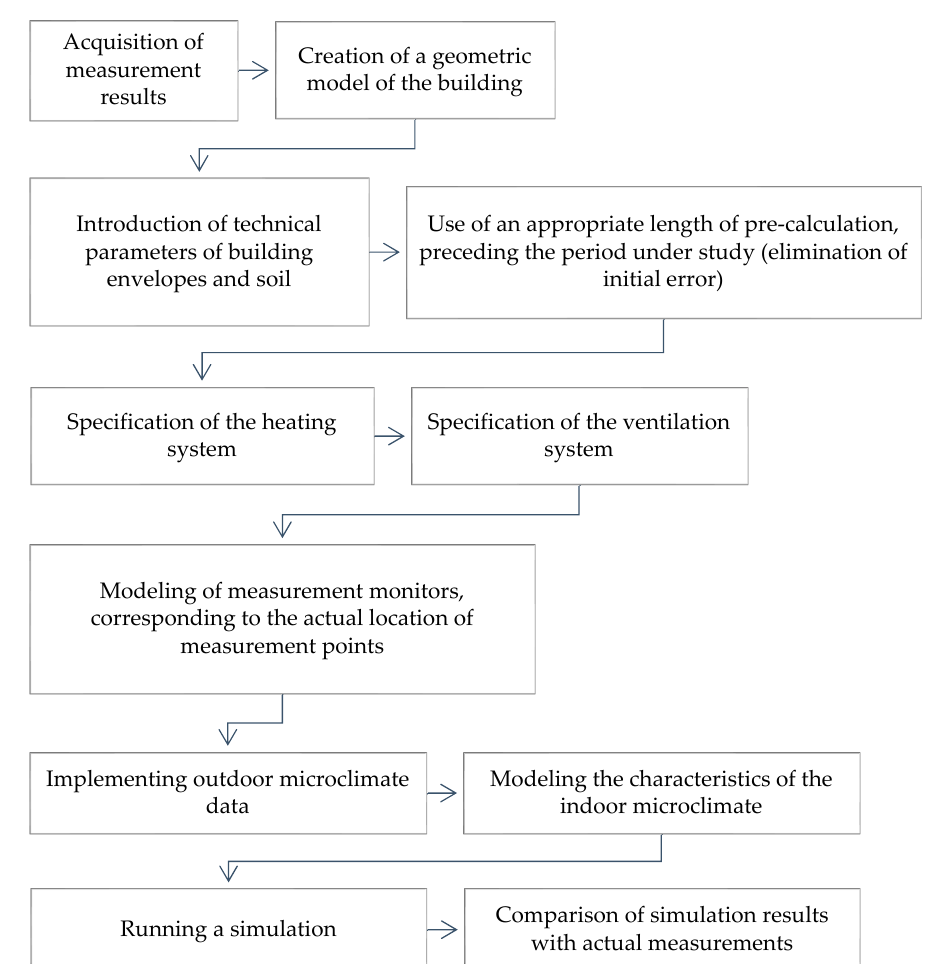
Figure 4. Schematic of the computational model validation process.